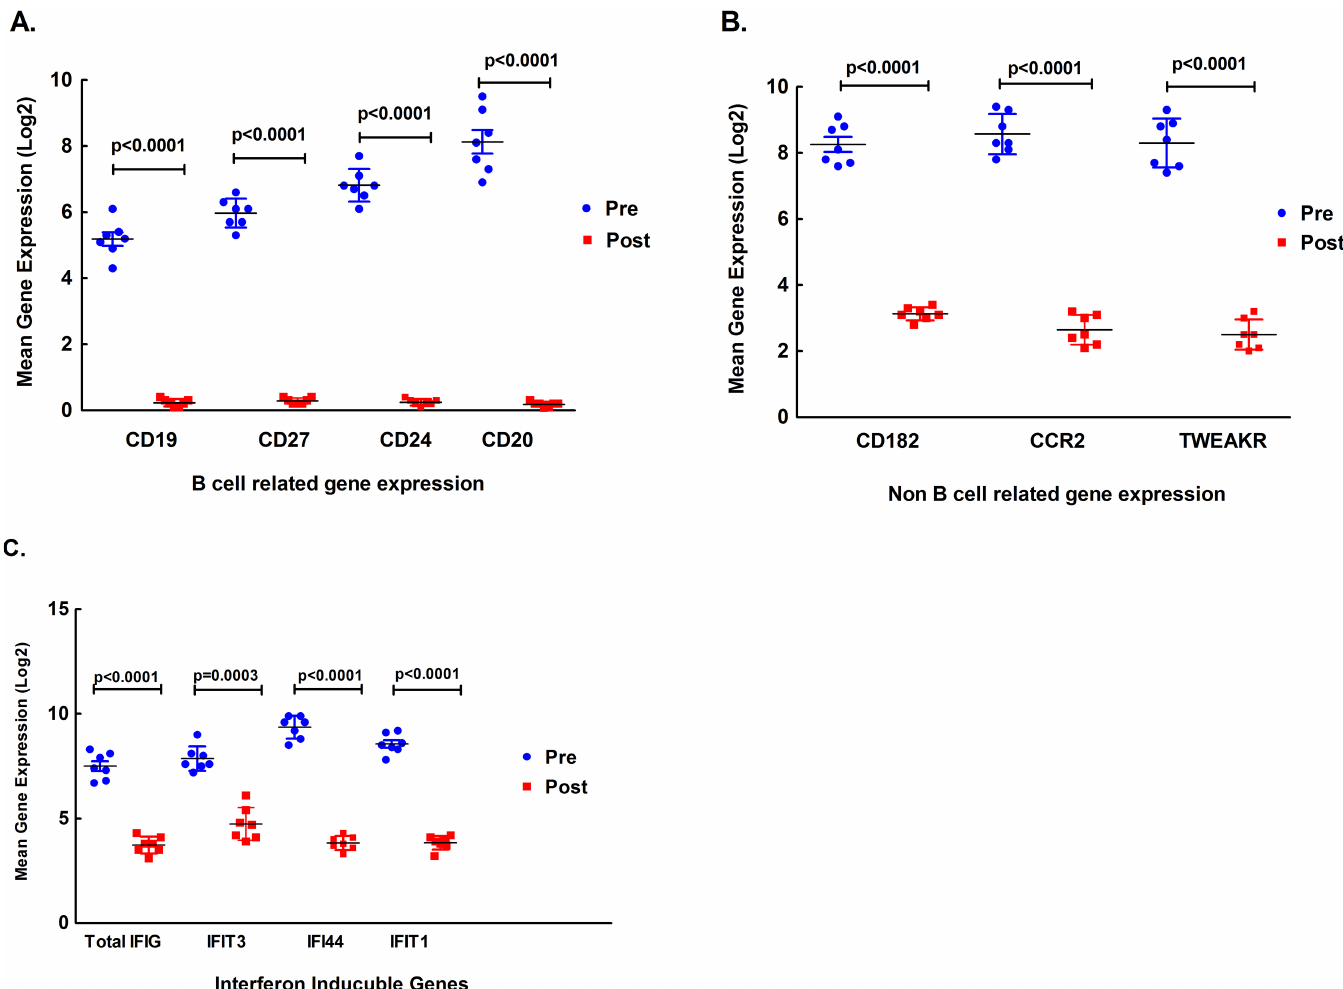
Fig 2. Validation of differentially expressedgenes identified by DNA Microarray analysis. Expression of genes related and unrelated to B cells are down regulatedwith Rituximab (RTX) treatment. As shown in Fig A, expression of B cell related genes CD19, CD27, CD24, and CD20 were significantly lower after RTX treatment than at baseline(p < 0.0001). Fig 2B shows expressionof non-B cell genesCD182, CCR2, and TWEAKR were all down regulated after RTX treatment than at baseline(p < 0.0001). Fig 2C shows expressionof IFIGs includingtotal IFIG (p < 0.0001), IFIT3 (p = 0.0003), IFI44 (p < 0.0001), IFIT1 (p < 0.0001) that were down-regulated after RTX